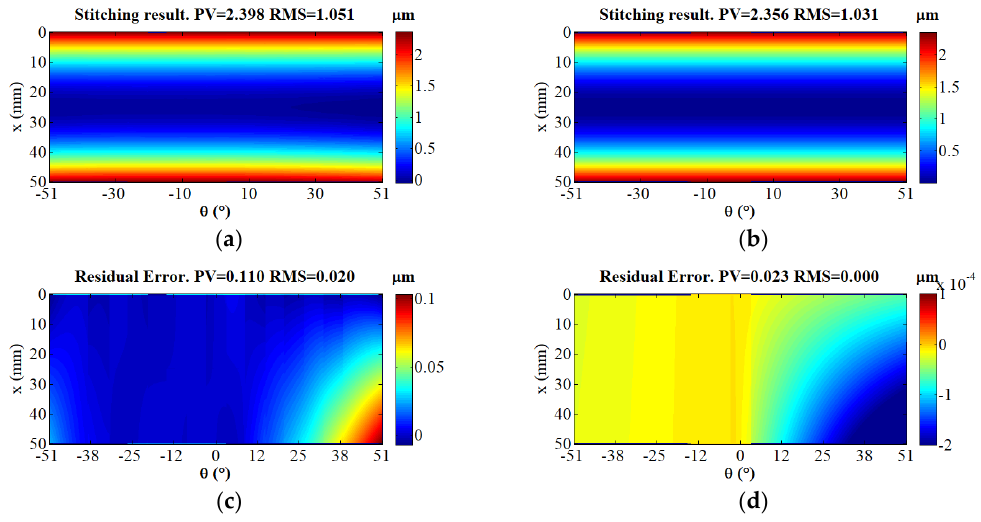
Figure 4. ( a ) The stitching result without using the iteration algorithm. ( b ) The result obtained with the proposed iterative method, ( c ) the residual error between the origin map and traditional method, and ( d ) the residual error between the origin map and iterative